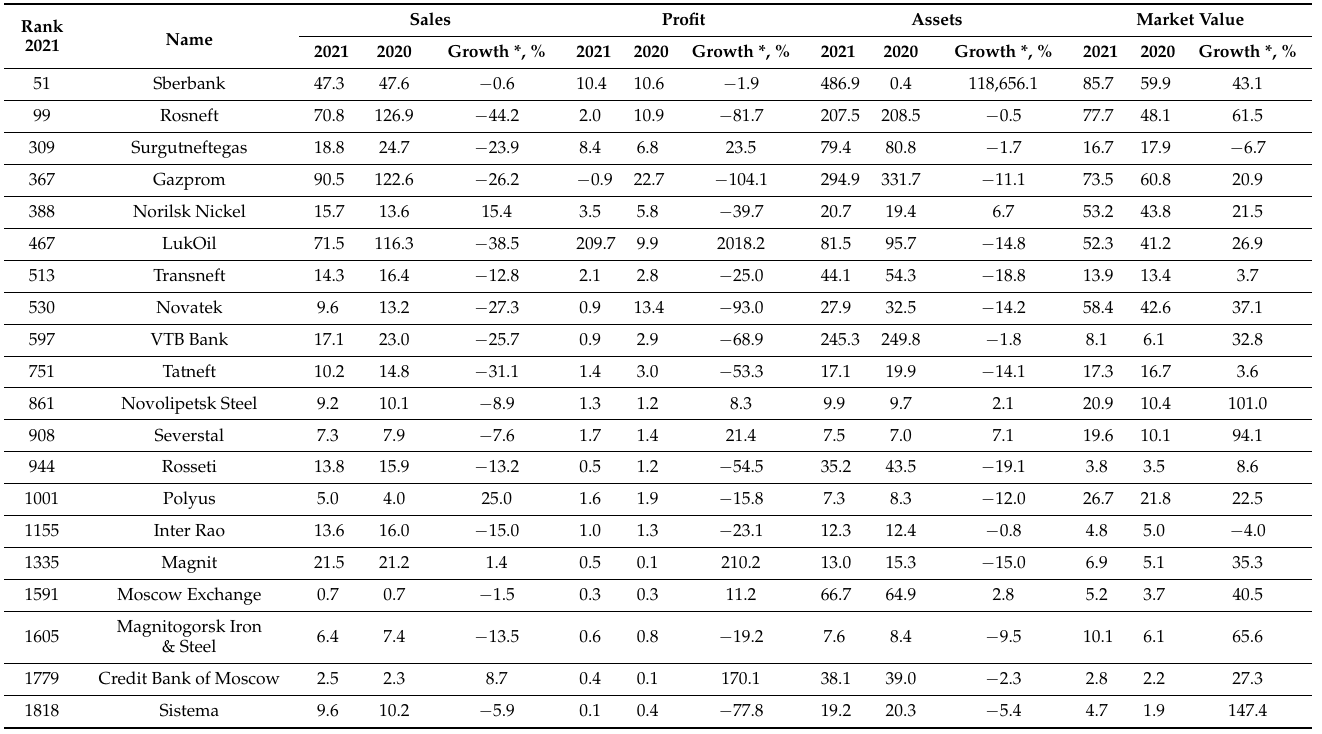
Table 1. Dynamics and growth of the financial risks of the largest Russian companies in the conditions of the COVID-19 crisis in 2020–2021 (as a result of the previous year), $